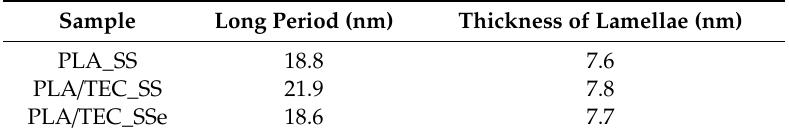
Figure 8. The diffraction patterns of neat (PLA_SS, PLA_MS) and plasticized PLA (PLA/TEC_SS, PLA/TEC_MS) samples. Table 4. Long period and thickness of lamellae of polylactide, polylactide / triethyl citrate system,